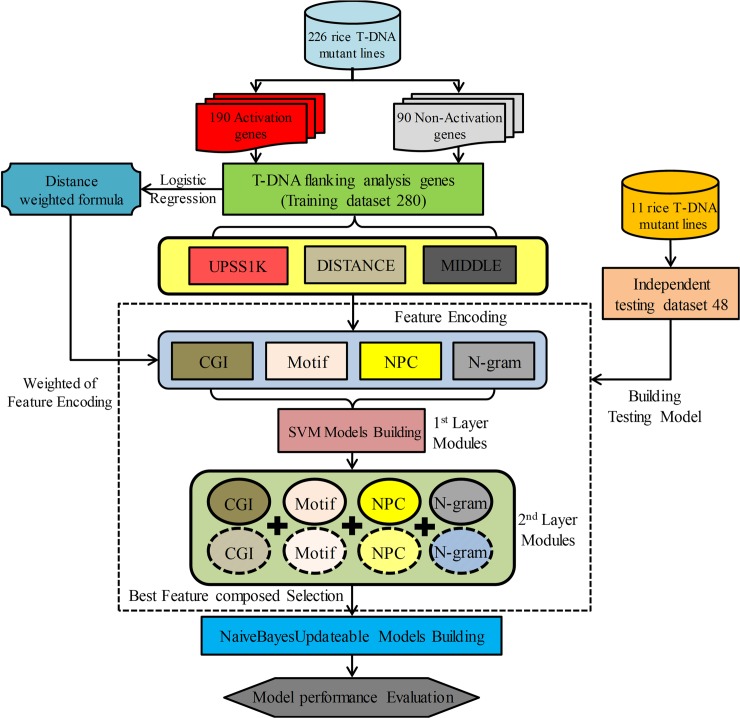
Flow chart of system architecture.The dotted line square indicates two-layer model construction. The solid and dotted circle line used for four kinds of features in 2nd Layer Modules indicates feature combination mechanism.